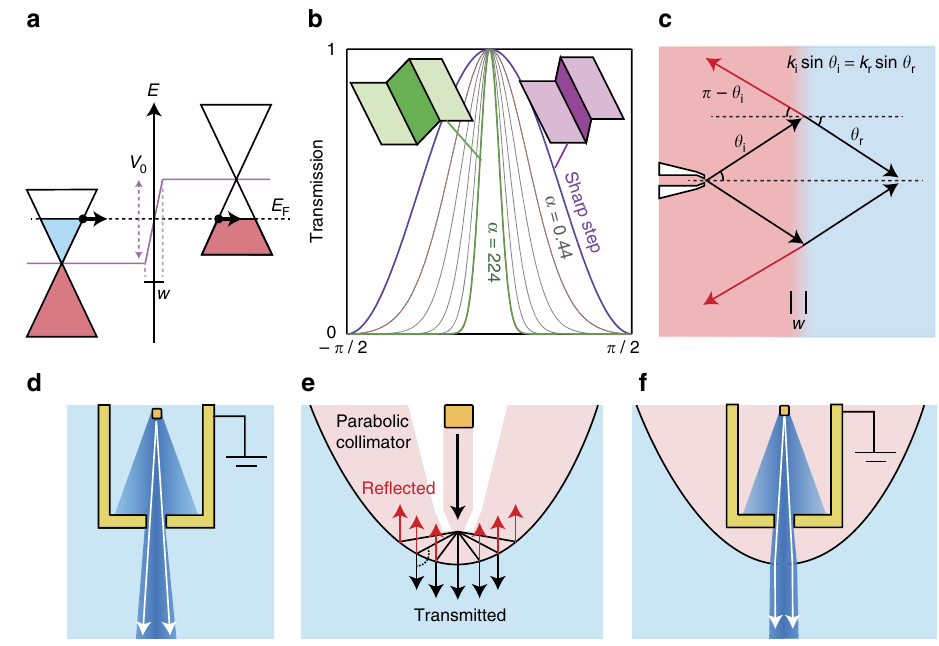
Figure 2 | Electron gun and optics. ( a ) Illustration of two Dirac cones offset by a potential step of height V 0 . The width of the potential step is w . Carriers moving from the left (n-type) to the right (p-type) perpendicular to the step, but cannot be backscattered due to conservation of pseudospin. ( b ) The transmission through a potential step depends strongly on a ¼ k F w , with large w exhibiting a larger chance of reflection at oblique angles. The analytical angular distributions 57 from sharp to soft ( w ¼ 40nm at n ¼ 10 12 cm (cid:3) 2 ) p–n junctions, with intermediate curves calculated by Cayssols interpolation curve 77 for a ¼ 0.44–244 are shown. ( c ) Electrons impinging on a p–n junction at an angle y i with respect to the normal, are transmitted/refracted according to Snell–Descartes law, or specularly reflected. ( d ) An aperture limiting the angular distribution. ( e ) A p–n junction lens with a parabolic shape and the point contact positioned in the focus, will co-align the transmitted trajectories. ( f ) A combination of an aperture and a parabolic lens produces an electron beam with a long focal